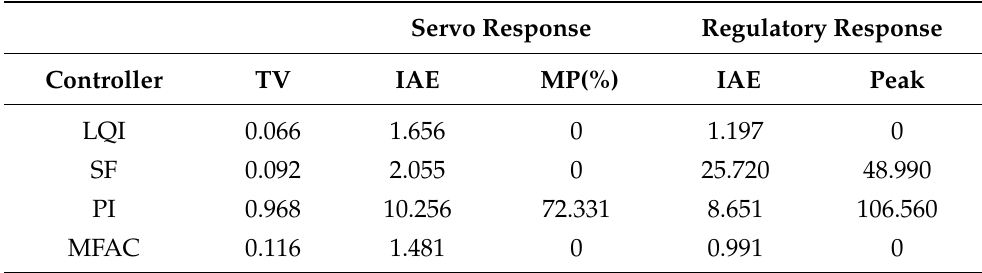
Table 3. Metrics of the perturbed system ( D = 0.45 and R o =